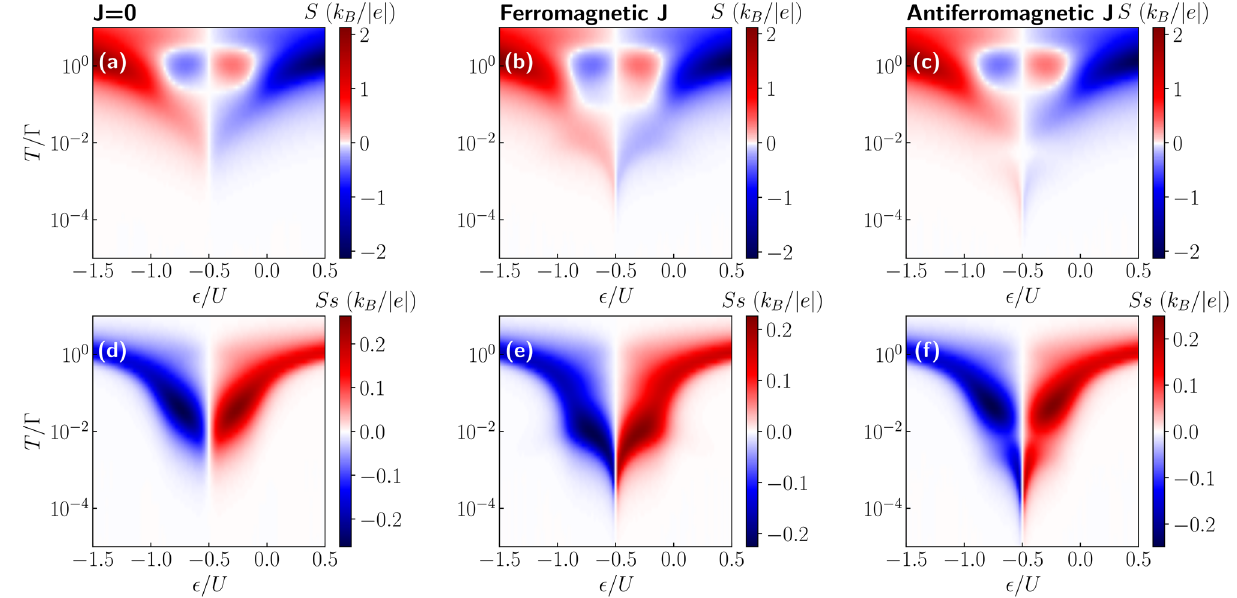
Figure 8. The spin Seebeck coefficient. ( a – c ) The Seebeck and ( d – f ) spin Seebeck coefficient as a function of temperature and orbital level position calculated for ( a , d ) J = 0 ( b , e ) ferromagnetic J and ( c , f ) antiferromagnetic J in the case of finite spin accumulation in the leads. The other parameters are the same as in Fig.